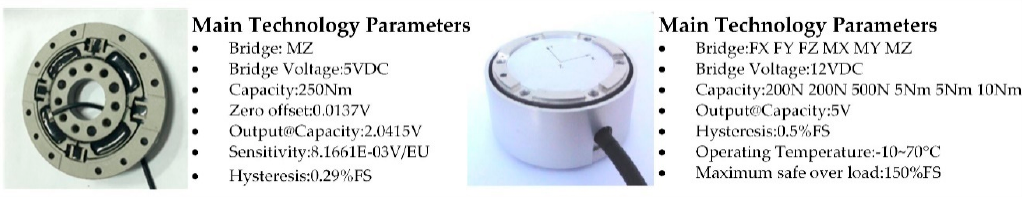
Figure 3. The detailed design of LLR-II leg mechanism.